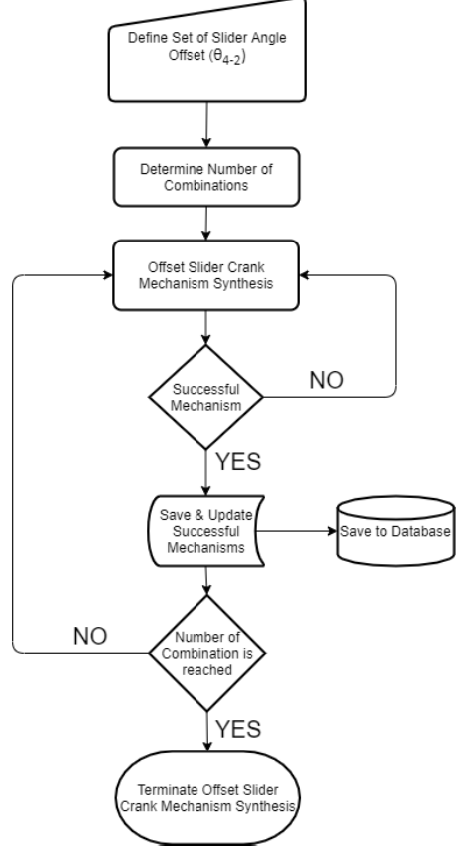
Figure 13. Algorithm for designing the offset slider – crank mechanism at the pharyngeal jaw.